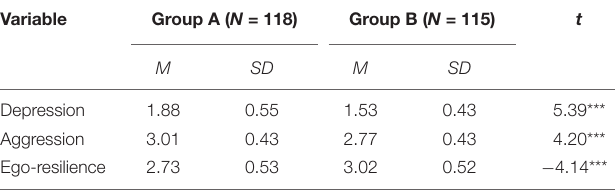
TABLE 2 | Differences in depression, aggression, and ego-resilience between groups A and B.